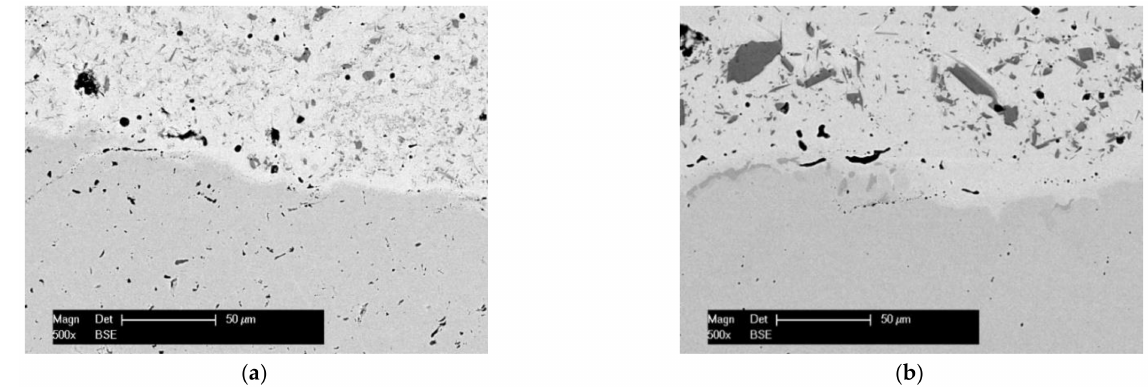
Figure 6. BSE micrograph of the interface at the FR ( a ) and VR ( b )